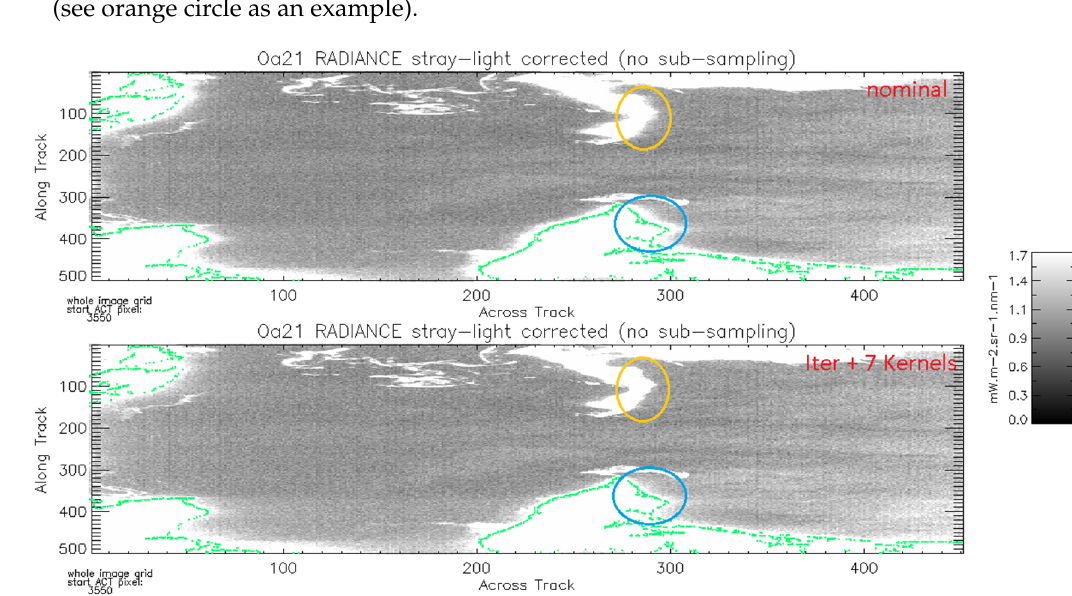
Figure 7. Earth Observation stray-light corrected Oa21 radiance in camera 4, in a region of the Gulf of Saint-Laurence where dark / bright (sea / land and sea / cloud) transitions occur. This measurement was done on 25 MAR 2020 ≈ 14h57 with OLCI-B. ( top ) nominal processing, ( bottom ) processing with iterations, and seven kernels. The green line represents the coastline. The yellow and blue circles give an example of where the improvement brought by the additive kernels (combined with the iterative method) happens. The orange and blue circles give examples of where the improvement happened (note, however, that it happened at all ACT bright / dark transition pixels).